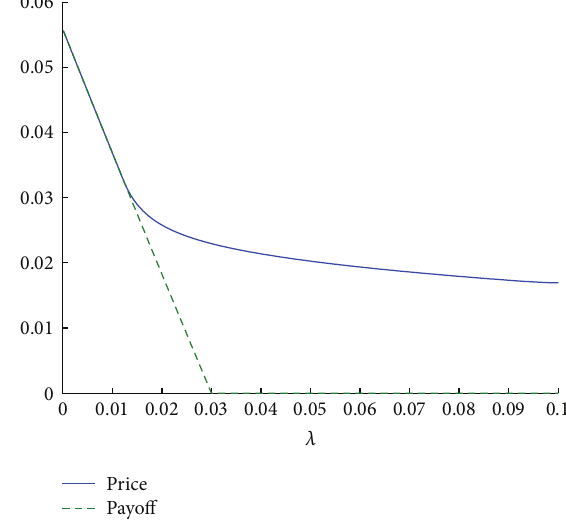
Figure 3: Prepayment option price 𝑃(𝜆) (solid line) and payoff 𝜒(𝜆) (dashed line) as a function of the intensity 𝜆 . Two regions appear: the continuation region 𝜆 > Λ ∗ and the exercise region 𝜆 ≤ Λ ∗